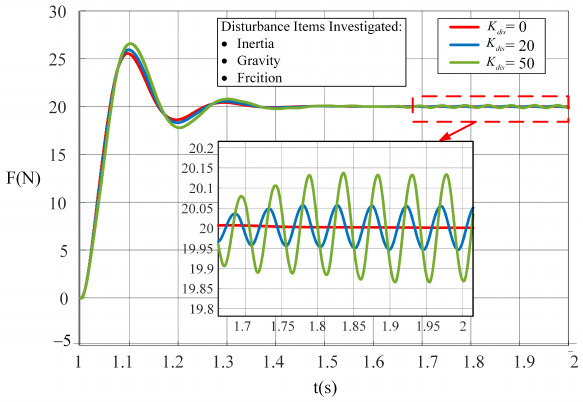
Figure 12. Force step response of the FOIC with inertia, gravity, and friction disturbances.